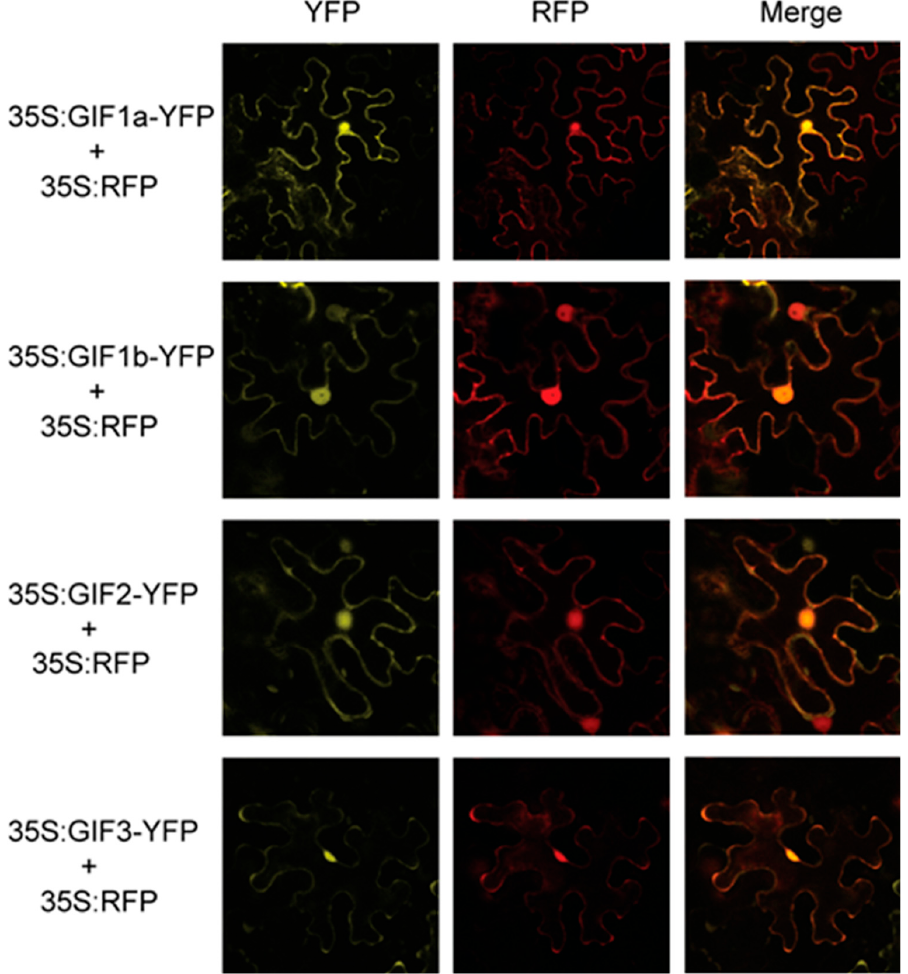
Figure 6. Subcellular localization of SlGIF– yellow fluorescent protein (YFP) fusion proteins. Tobacco leaves was infiltrated with Argobacterium tumefaciens ( A. tumefaciens ) containing a recombination vector (35S: GIFs-YFP) and a nuclear marker RFP (red fluorescent protein).